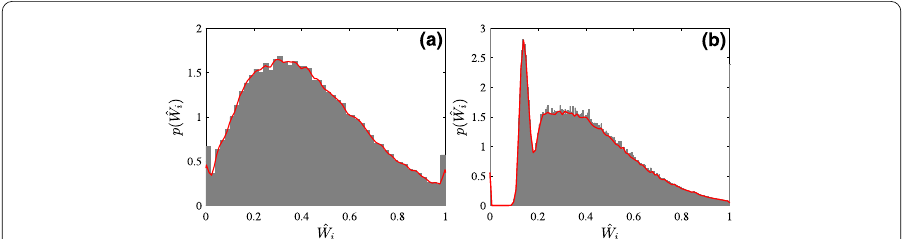
( k -means and H / T break) to uncover the discrete hierarchical structure of the node with k > 100 based on the normalized weights